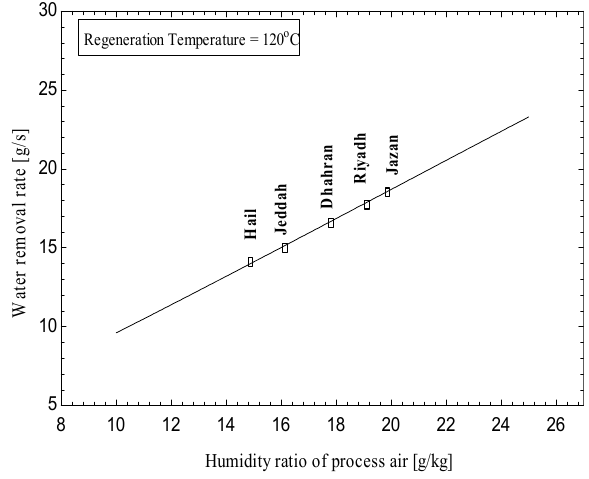
Figure 9. Variation water removal rate with inlet air humidity ratio.